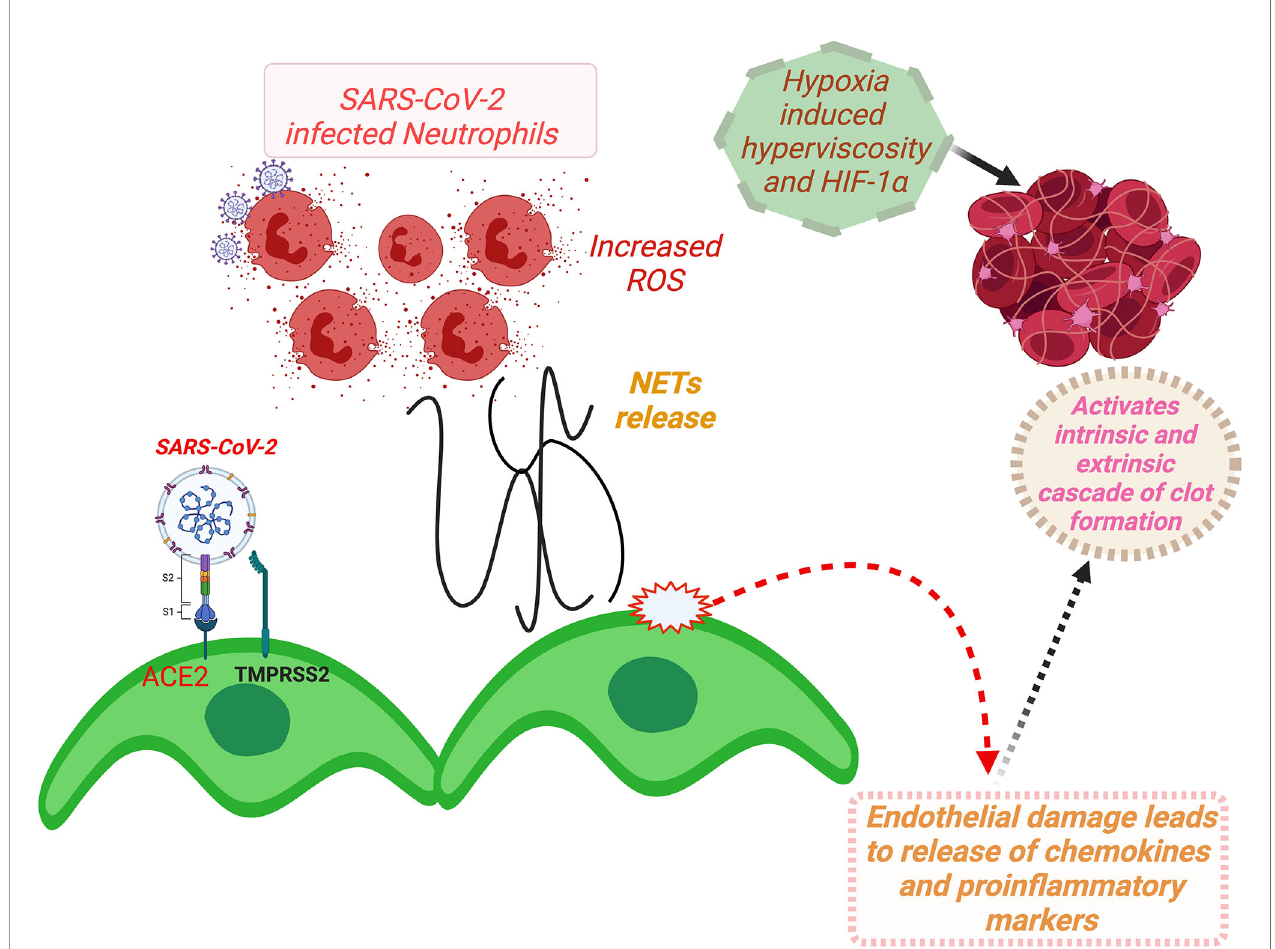
FIGURE 6 | A schema for ACE2-mediated dysfunction of vascular endothelium leading to thrombosis in COVID-19 patients. (Binding of SARS-CoV-2 to ACE2 receptor expressed at the vascular endothelial cell surface leads to internalization and replication of the virus inside the cell and consequently endothelial dysfunction that activates prothrombotic cascade. Additionally, SARS-CoV-2 binding induces downregulation of ACE2, resulting in imbalances of ACE/ACE2 ratio, and dysregulation of RAAS, favoring prothrombosis. Both of these stated mechanisms in consequence also induce activation and aggregation of the platelets, altogether culminating in intravascular thrombosis. Furthermore, NETs that cause increased concentrations of intracellular ROS in neutrophils inducing vascular endothelial dysfunction and activation of coagulation pathways. Furthermore, hypoxia-induced hyperviscosity and upregulation of the HIF-1 a signaling pathway can be contributing to the vascular thrombosis.) HIF-1 a , hypoxia-inducible factor 1alpha; NETs, neutrophil extracellular traps; ROS, reactive oxygen species; ACE2, angiotensin-converting enzyme-2; TMPRSS2, transmembrane serine protease 2; COVID-19, coronavirus disease 2019; SARS-CoV-2, severe acute respiratory syndrome coronavirus 2; RAAS, renin – angiotensin – aldosterone